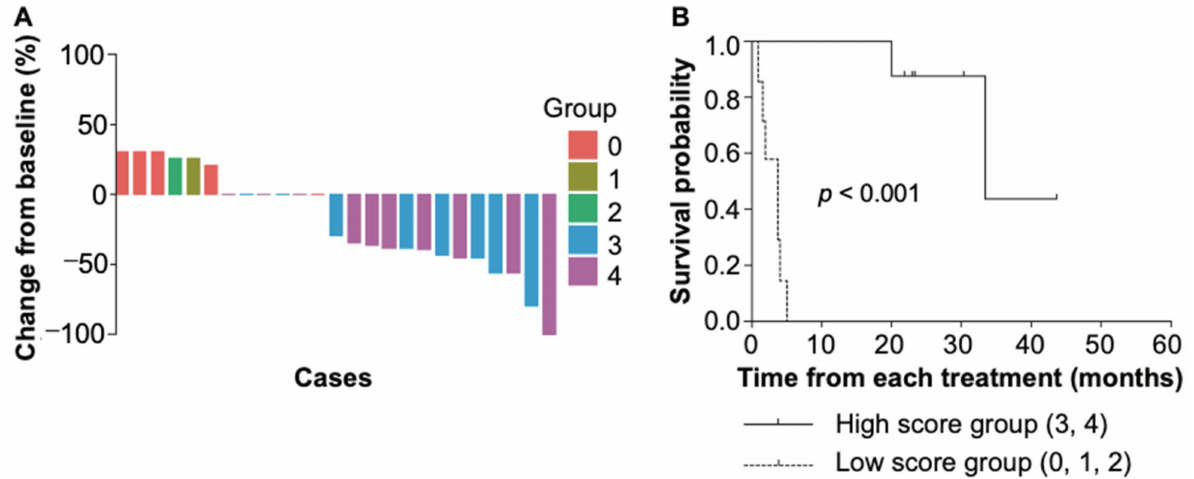
Figure 3. Therapeutic outcomes according to the protein expression quantified by selected reaction monitoring assay. ( A ) Best percent changes in tumor size by RECIST criteria based on the selected reaction monitoring marker groups. ( B ) Kaplan-Meier curve presents progression-free survival in cases, according to the selected reaction monitoring marker groups. RECIST, response evaluation criteria in solid